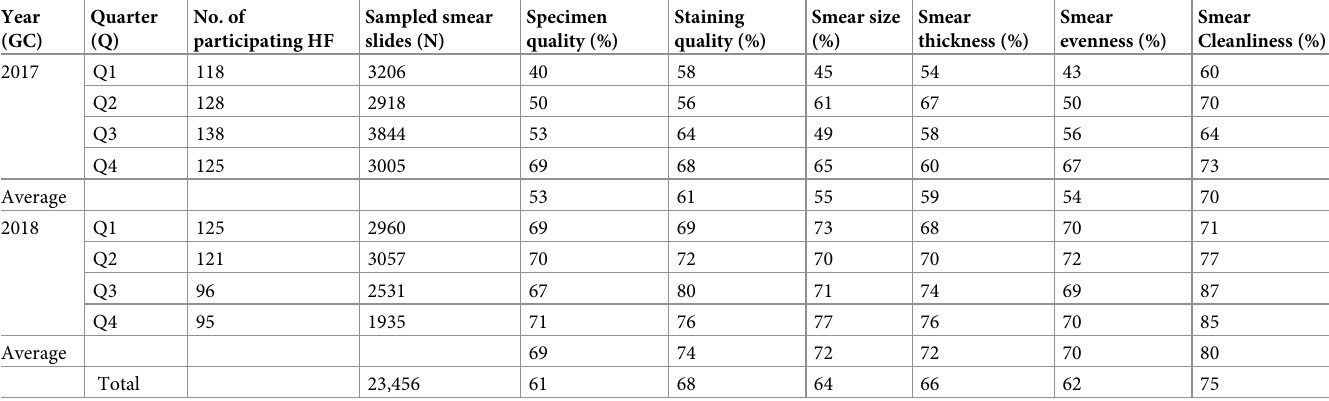
Table 1. Trends of participation and smear quality assessment in public health facilities from January, 2017 to December, 2018 year.